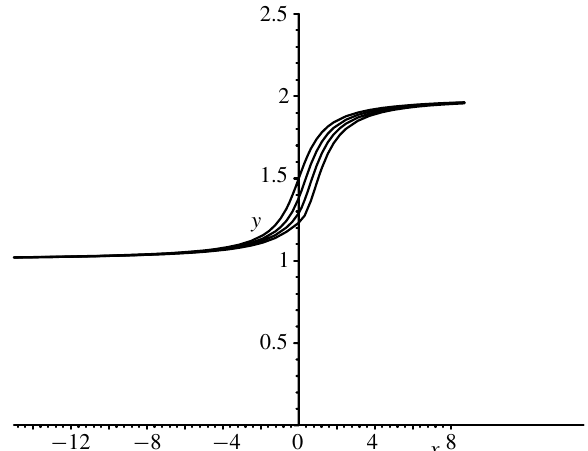
Figure 3.1 . Graph of third degree Maclaurin polynomials for Burger’s equation using modified Picard iteration at t = 0 . 25, 0 . 5, 0 . 75, and 1 .